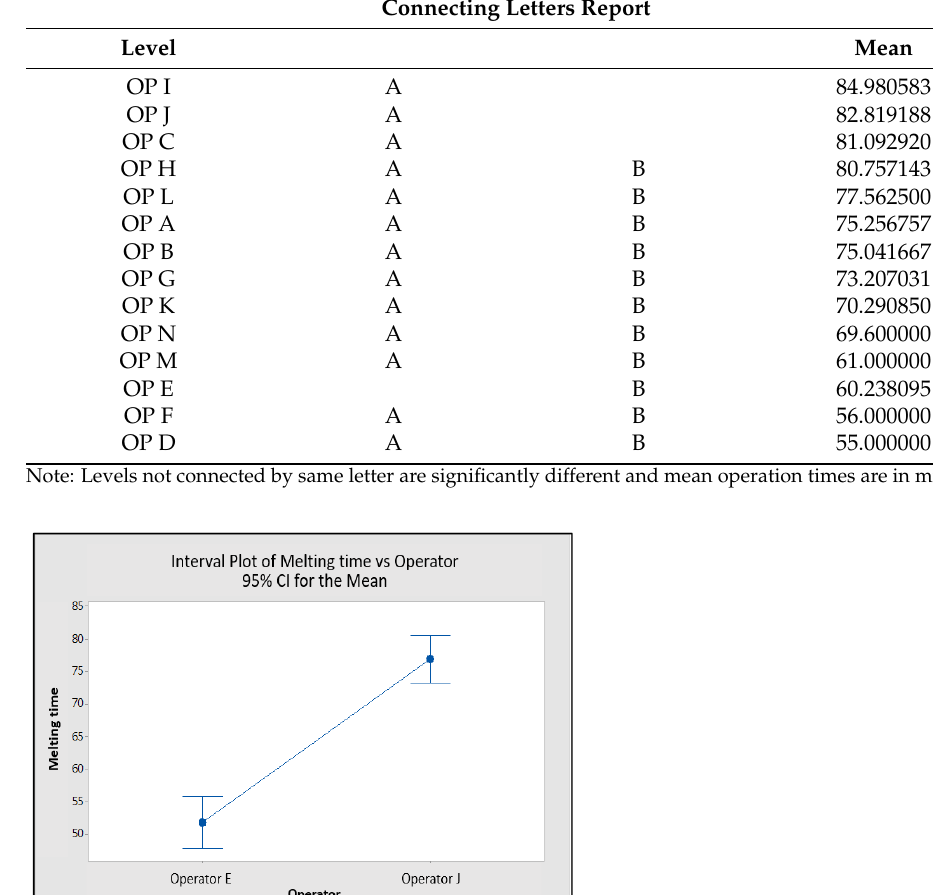
Table 2. The results of grouping operators.